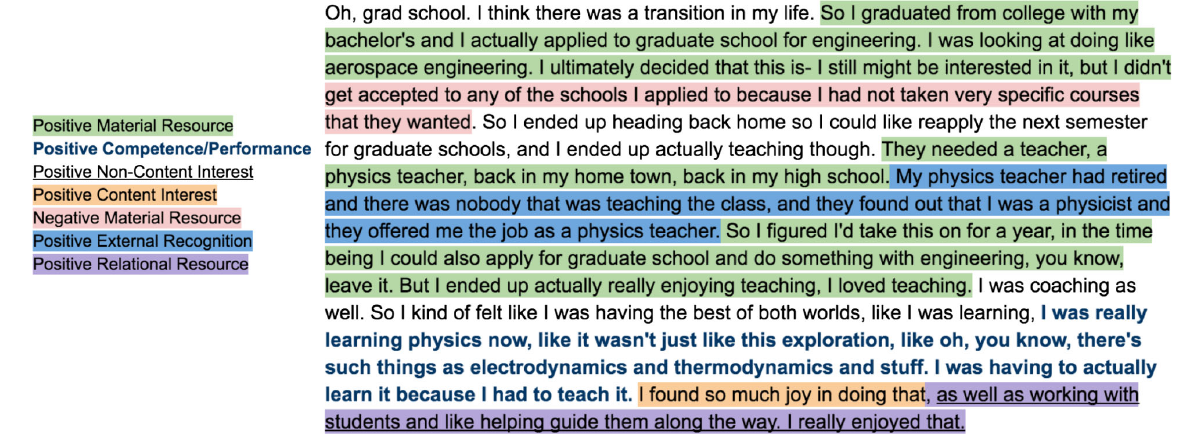
FIG. 4. An excerpt from Owen ’ s coded interview using the Critical Physics Identity